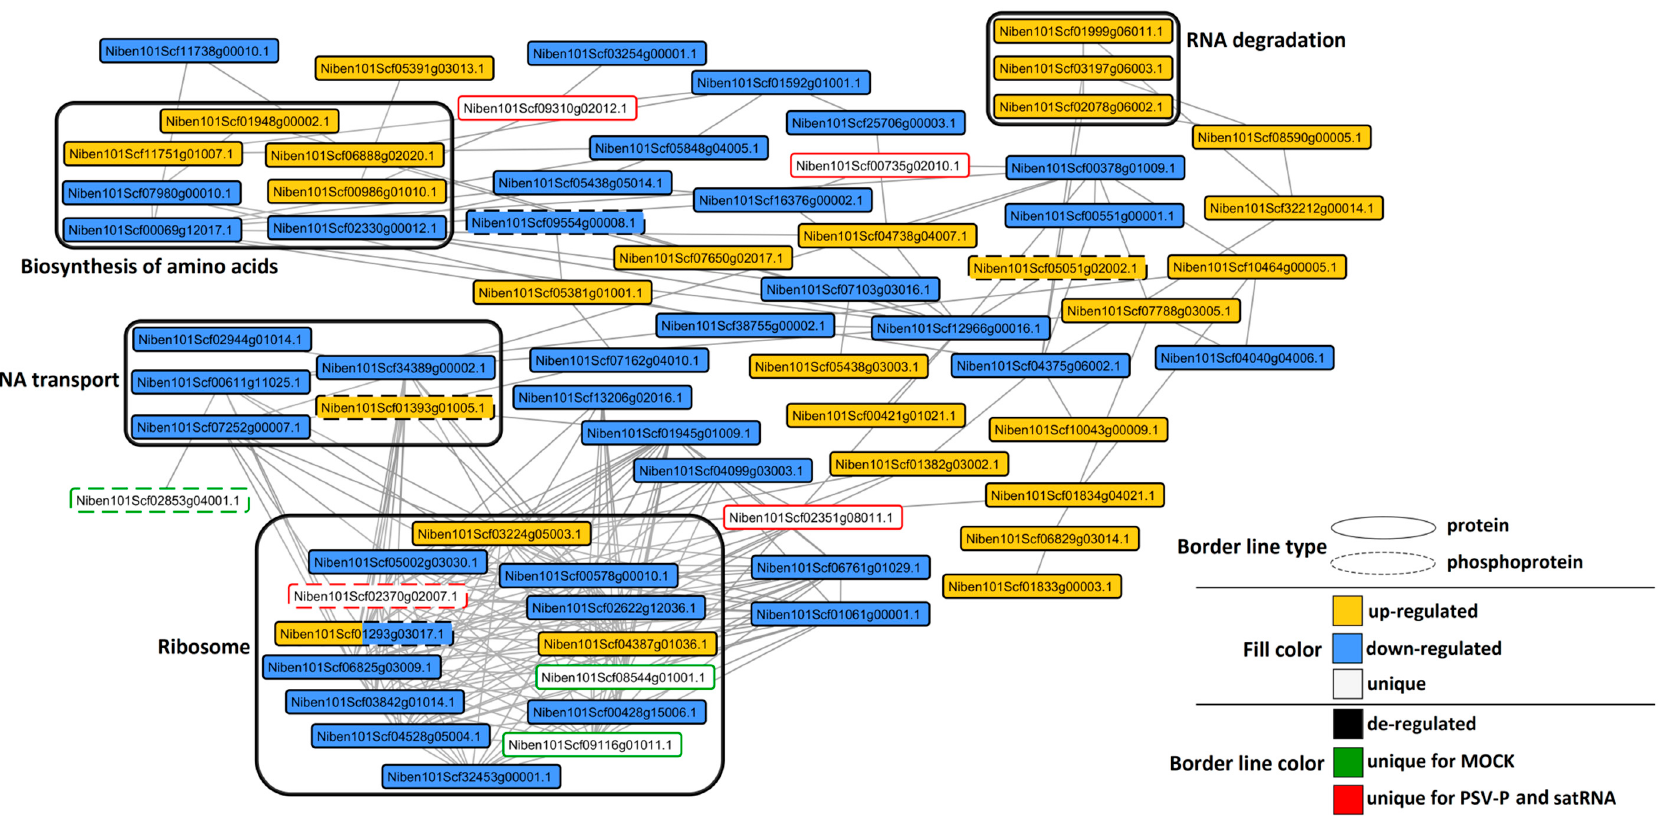
Figure 9. Protein–protein interaction networks of N. benthamiana PSV-P and satRNA-responsive (phospho)proteins, differentially changed in their abundance. Cytoscape was used for visualization with SolGenomics N. benthamiana identifiers for (phospho)proteins. Grouping according to KEGG pathways was done for at least three interacting (phospho)proteins.